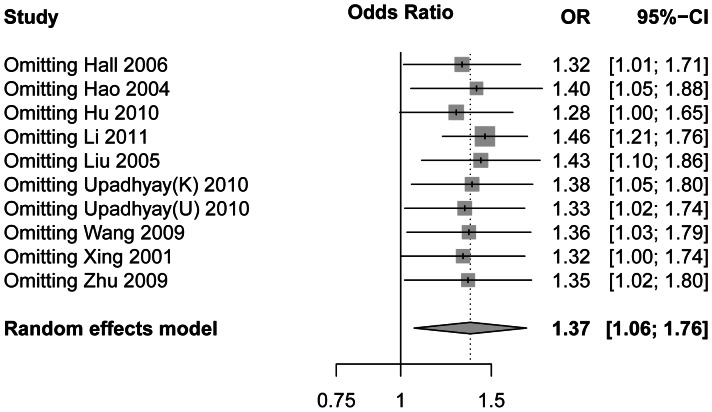
Results of odds ratios (ORs) with 95% confidence limits (CIs) in sensitivity analysis.Results were computed by omitting each study. Random-effects estimates were used. Each OR means the result when remove the corresponding study.